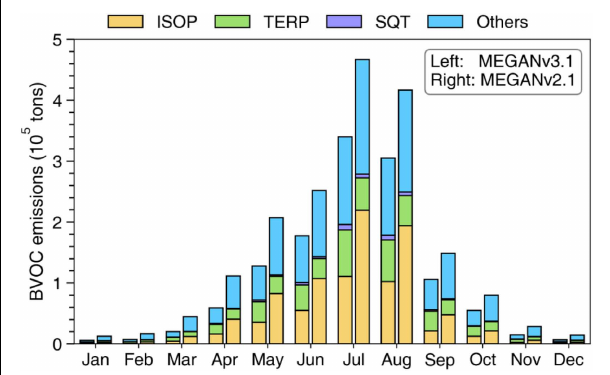
FIGURE 2 | Monthly emission budget of BVOC over SCB for 2017 estimated by MEGANv2.1 and MEGANv3.1.